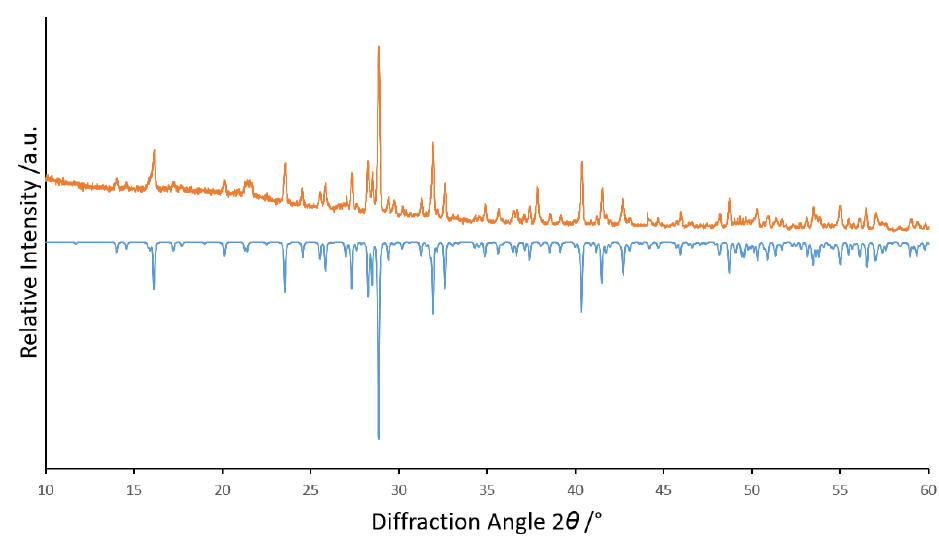
Figure 1. Powder X-ray diffractogram of (Y 2.9 Er 0.1 )F[Si 3 O 10 ] ( top : measured in orange, bottom : calculated in blue with data from [3]).